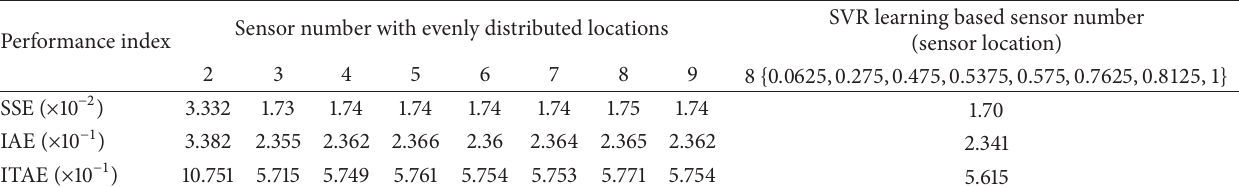
Table 1: Performance index comparisons (SVR learning based sensing locations versus evenly distributed